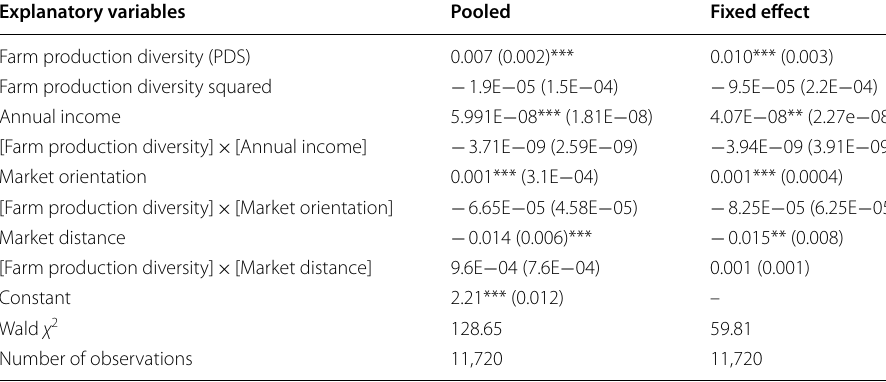
Authors’ analyses using 3 rounds of BIHS panel data. The dependent variable is HDDS ***, and ** indicate significance at the 1% and 5%, levels, respectively; figures in the parentheses indicate standard